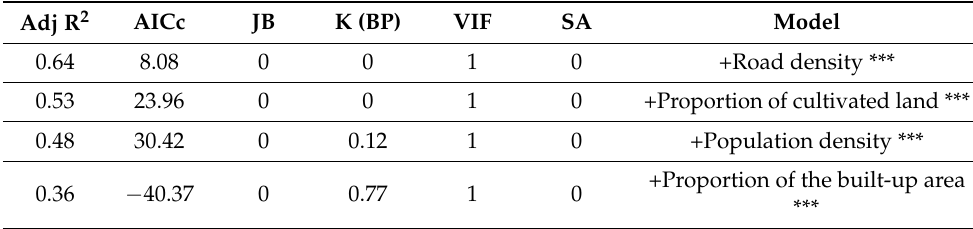
Table A3. The highest adjusted R 2 results of the explanatory regression with the PD and one independent variable.